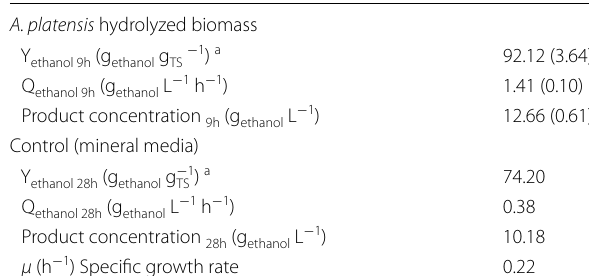
Table 3 Ethanol yield, volumetric productivity and product concentration for ethanol production from A. platensis hydrolyzed biomass and mineral